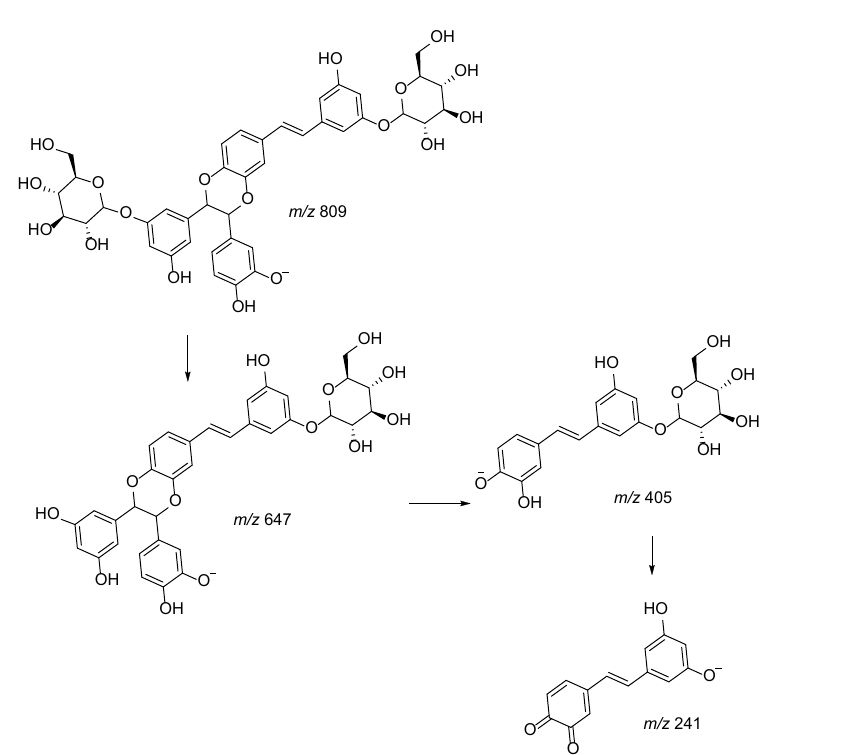
Figure 4. Proposed fragmentation pattern of piceaside with furanic group.